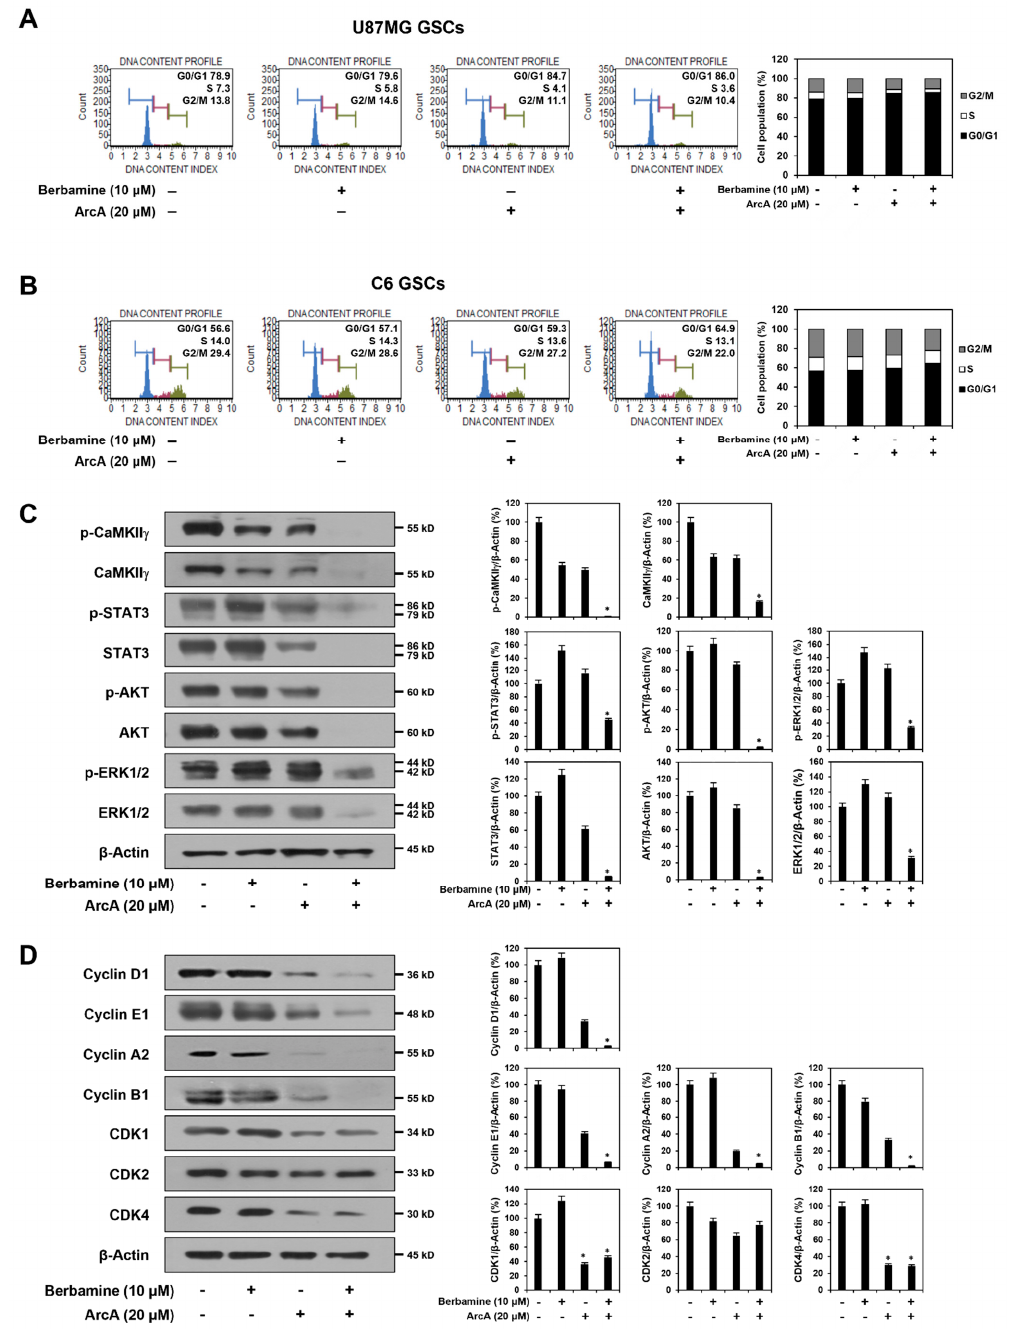
Figure 3. Combined treatment of berbamine and ArcA potently downregulates CaMKII γ -mediated growth signaling pathway. ( A – D ) U87MG- and C6-derived GSCs were treated with the indicated concentrations of berbamine and ArcA for 24 h. ( A , B ) Effect of combined treatment of berbamine and ArcA on the cell cycle in both GSCs. Cell cycle distribution was detected using a Muse Cell Analyzer with Muse ® Cell Cycle kit. ( C ) Effect of combined treatment of berbamine and ArcA on the CaMKII γ -mediated STAT3/AKT/ERK1/2 signaling pathway in U87MG-derived GSCs. ( D ) Effect of combined treatment of berbamine and ArcA on the expression of cell cycle regulatory proteins in U87MG-derived GSCs. ( C , D ) Protein levels were detected by Western blot analysis using specific antibodies and were further quantified by densitometry. β -Actin levels were used as an internal control. * p < 0.05 vs. the compound alone or the